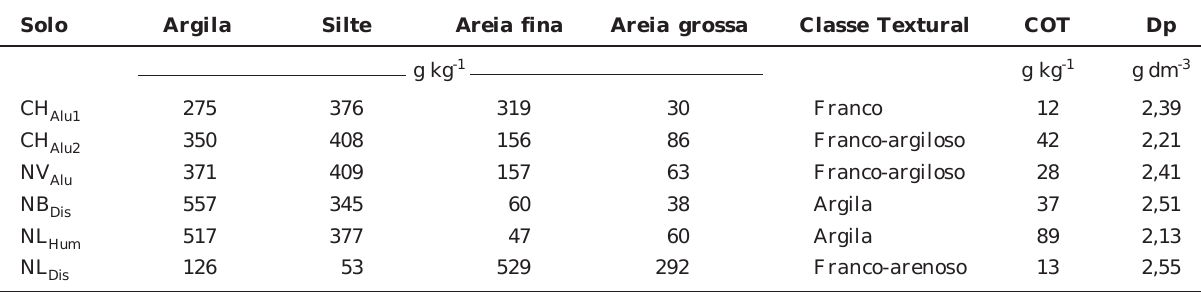
= Cambissolo Húmico alumínico típico 2; NV Alu2 = Neossolo Litólico húmico típico; NL Hum